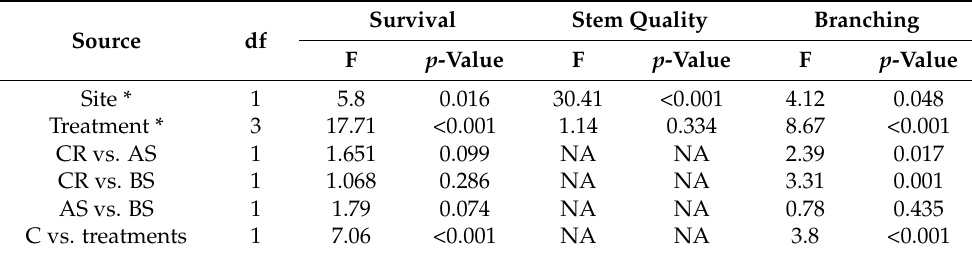
Table 4. Analysis of variance results with orthogonal contrasts for individual jack pine tree survival ( n = 560), stem quality ( n = 360), and branching ( n = 360) after vegetation management treatments (C = control, BS = motor-manual brushsaw, AS = aerial spray, CR = complete removal) applied on two sites (Bending Lake and E.B. Eddy) in Ontario, Canada.